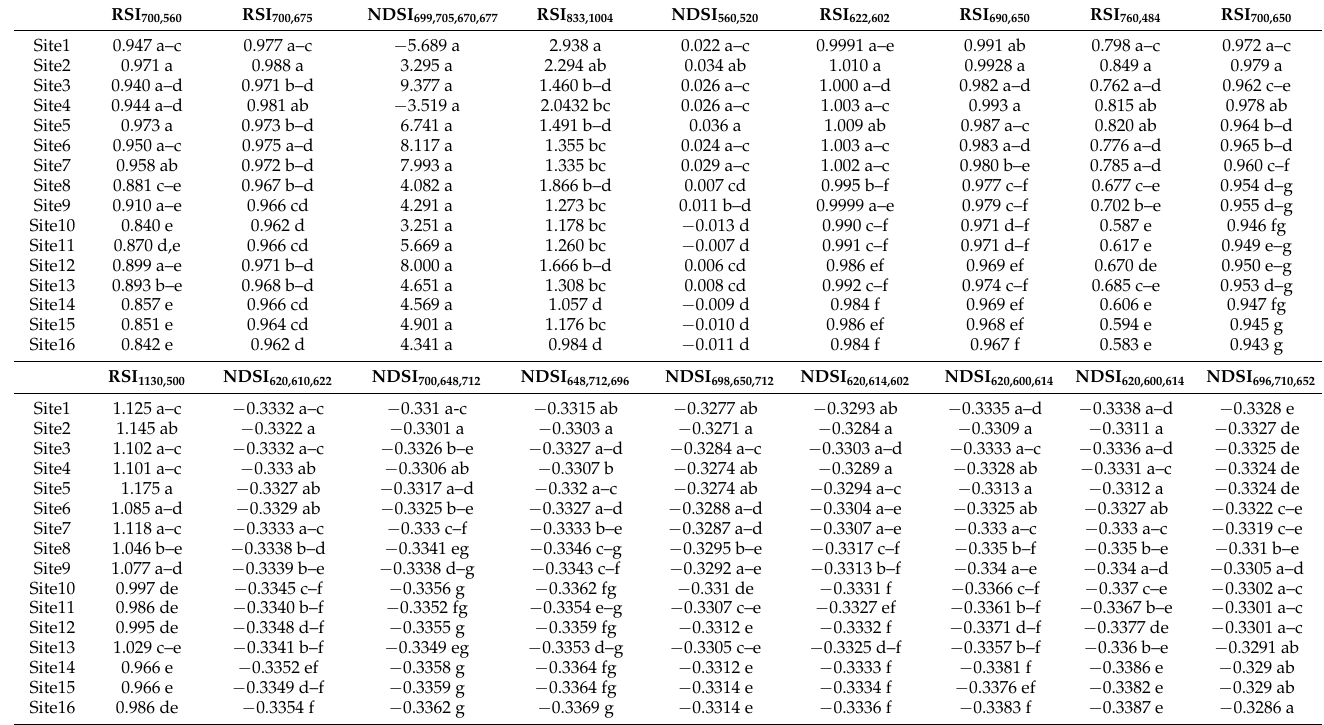
scale) of the discovered best R 2 . Table 6 shows the R 2 values for the association between the four measured WQPs and PSRIs (NSRIs-2b and NSRIs-3b). Table 5. Variation values of 18 SRIs of water samples as averaged over two years for sixteen surface water